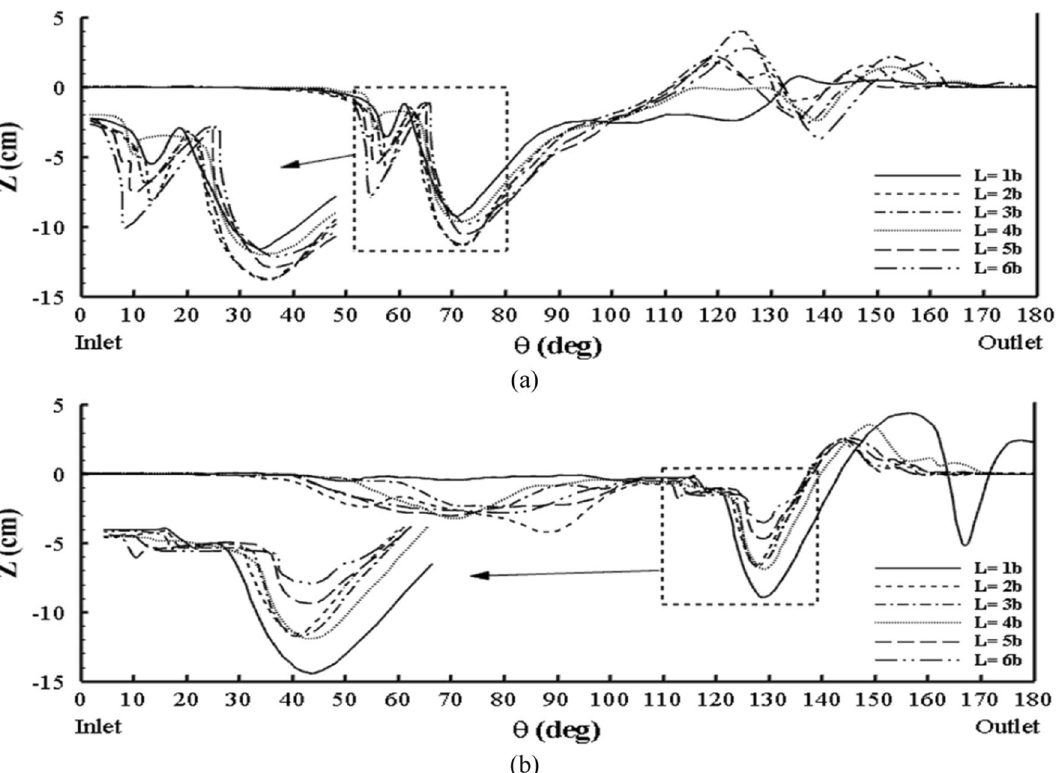
Fig. 11 Longitudinal sections in the center of channel width surrounding the combination of piers and collar installed at a 60- and b 120-degree positions of the